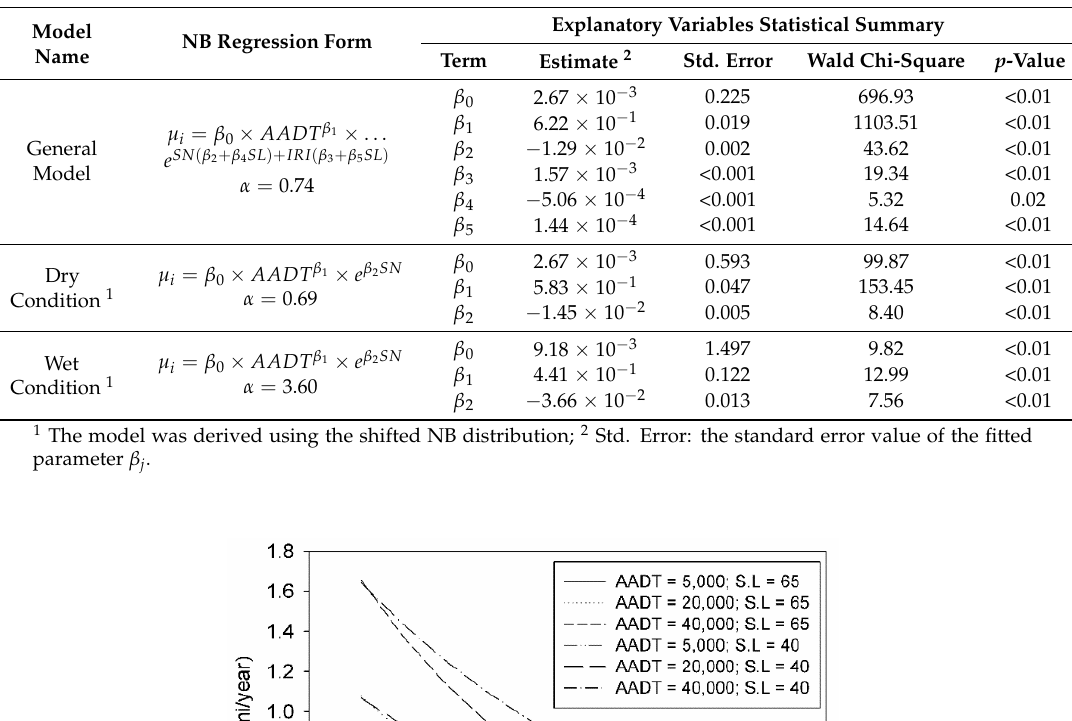
Table 1. Statistical summary of all fitted NB regression models.